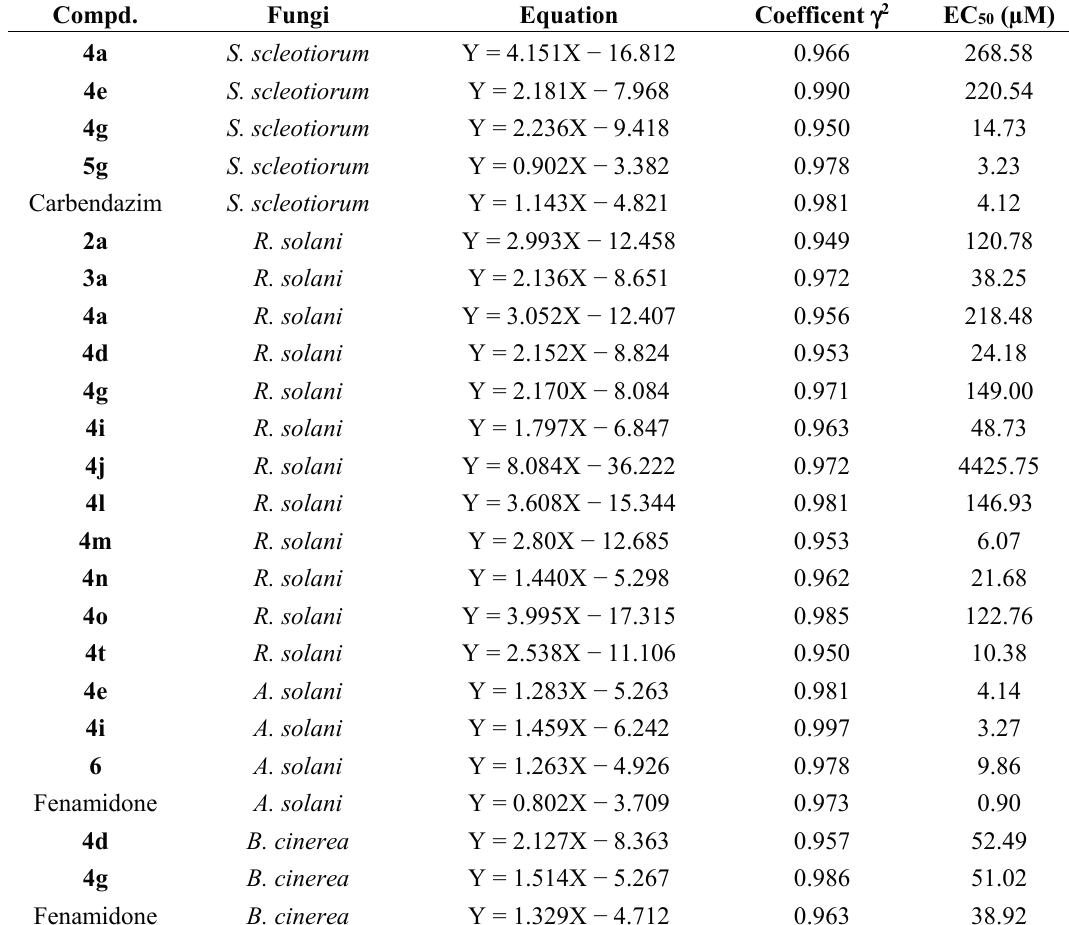
Table 2. The EC 50 values of compounds 4 and 5 against different phytopathgens.